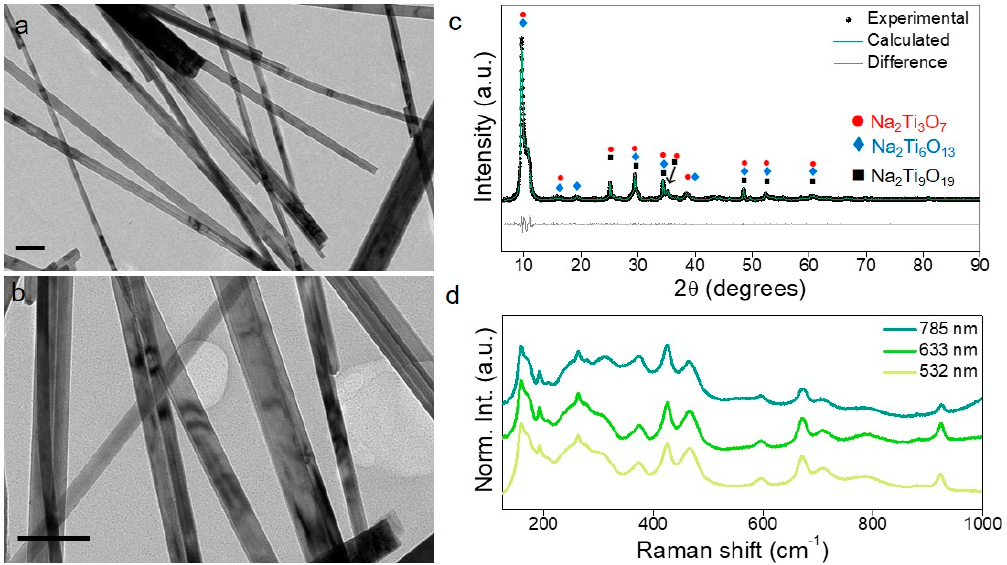
Figure 1. Characterization of the Ti NWs: ( a , b ) TEM images of the as-synthesized wires (scale bars represent 200 nm), ( c ) powder XRD pattern, and ( d ) room temperature Raman spectra registered with three different excitation wavelengths.